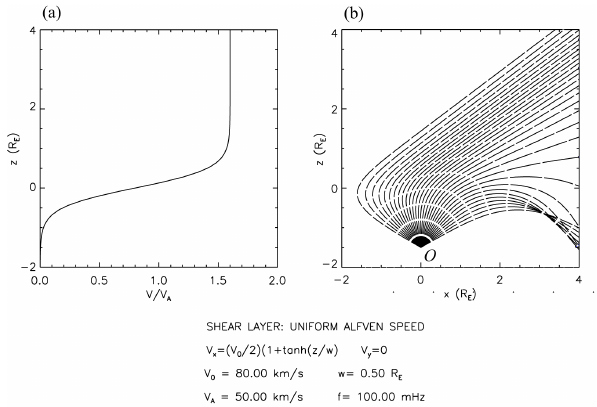
Figure 2. Isotropic Alfvén waves originationg from a point source O in a shear layer. (a) The layer profile. (b) The results of ray trac- ing. The ray pattern is interrupted at equal time intervals for a fea- ture on the wave packet travelling at the ray velocity. The interrup- tions therefore trace out the pattern of the wave